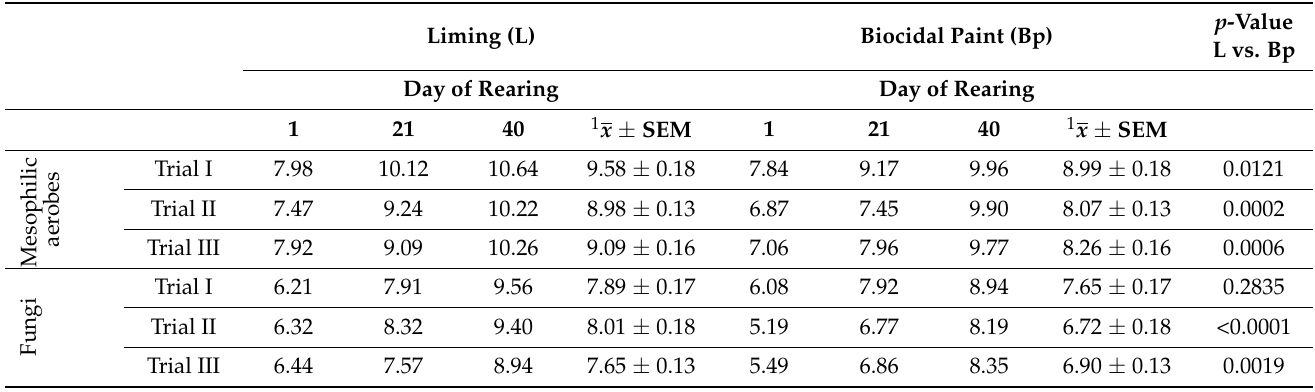
p -Value L vs. Bp